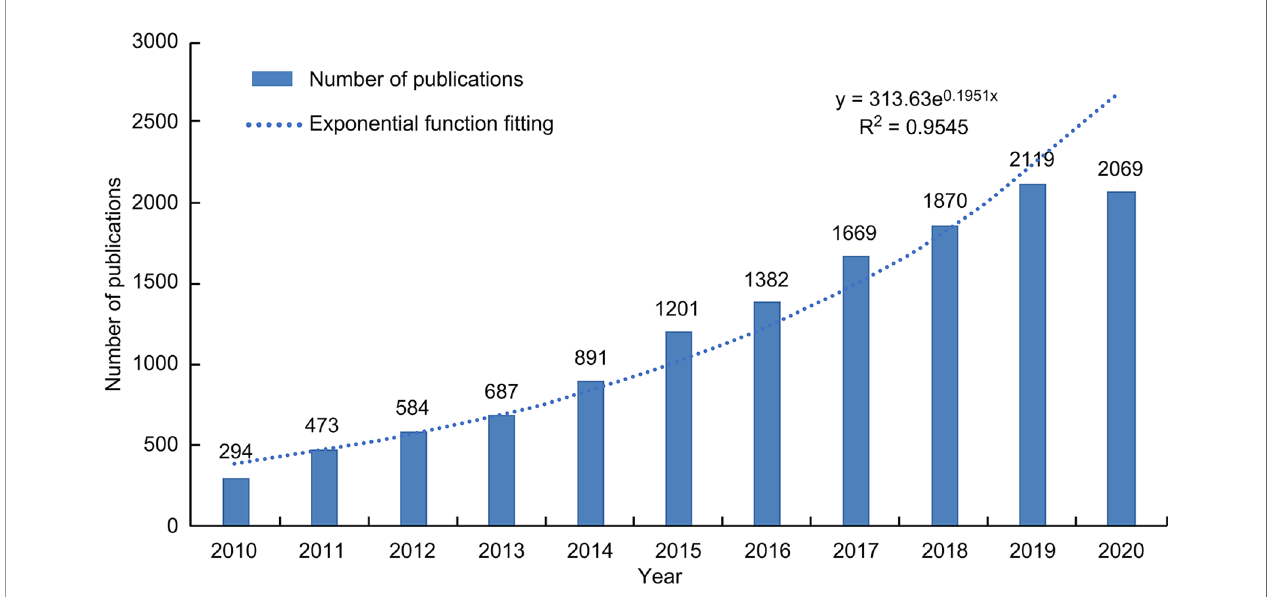
FIGURE 1 | The trend of TNBC research from 2010 to